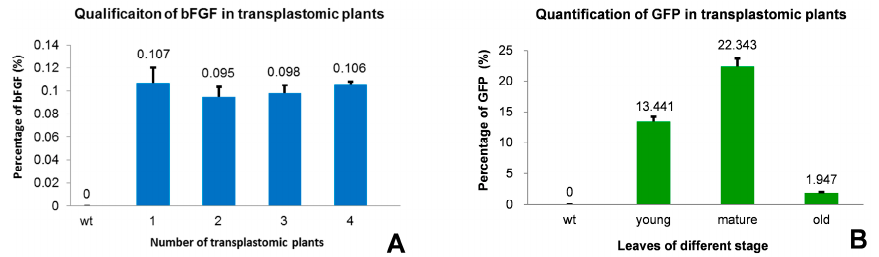
Figure 4. Quantification of bFGF and GFP in transgenic tobacco plants. ( A ) Level of bFGF expression in the leaves of four independent transgenic plants was shown in relation to total soluble protein (mean ˘ SD). 1–4, independent transplastomic plants; wt, Wild-type plant; ( B ) Level of GFP expression in young, mature and old leaves of transplastomic plants; wt, Wild-type plant. All measurements were made in